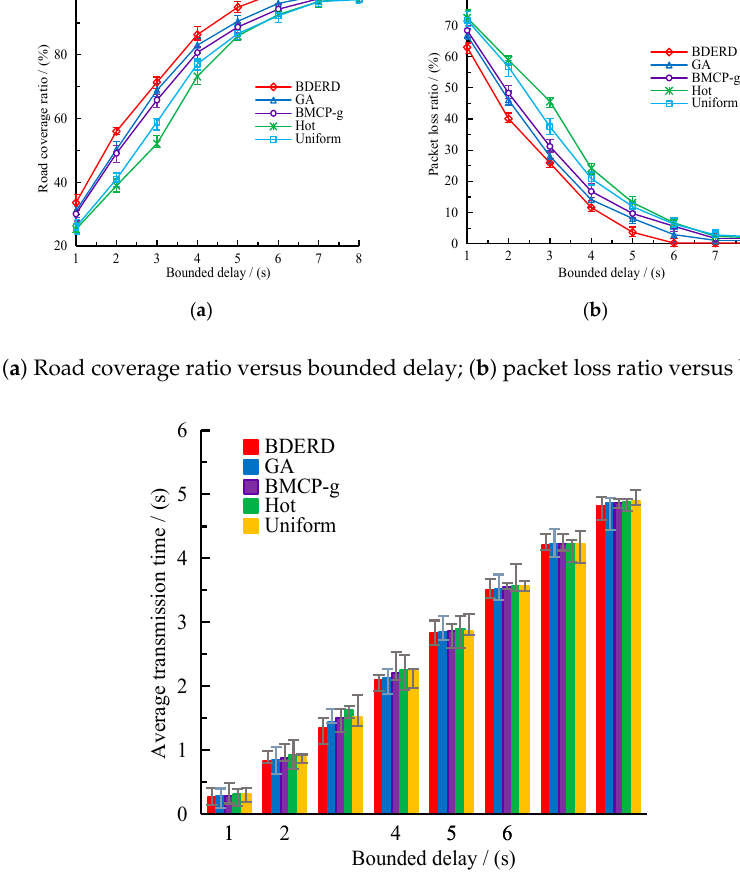
Figure 5. Average transmission time versus the bounded delay.